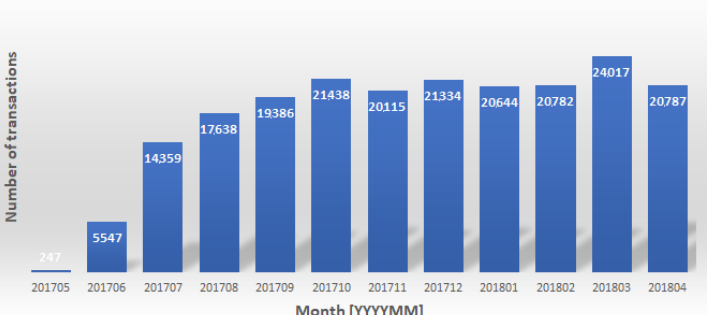
Figure 11. A number of selected transactions per month, for Risk max = 0.01.